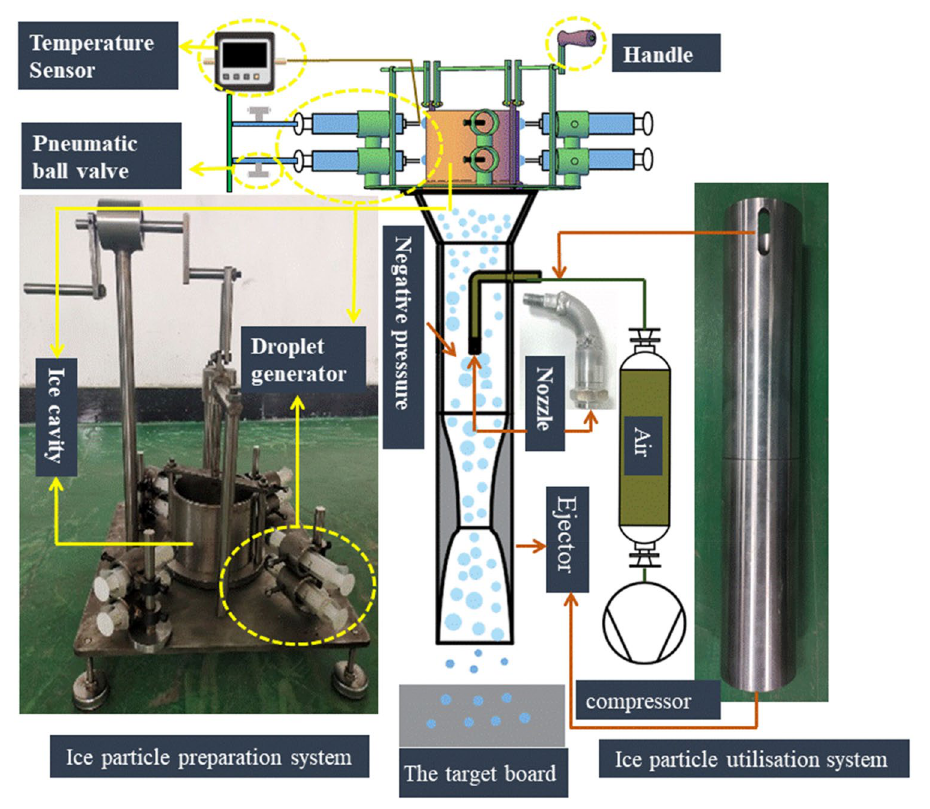
Figure 2. Experimental system for ice abrasive